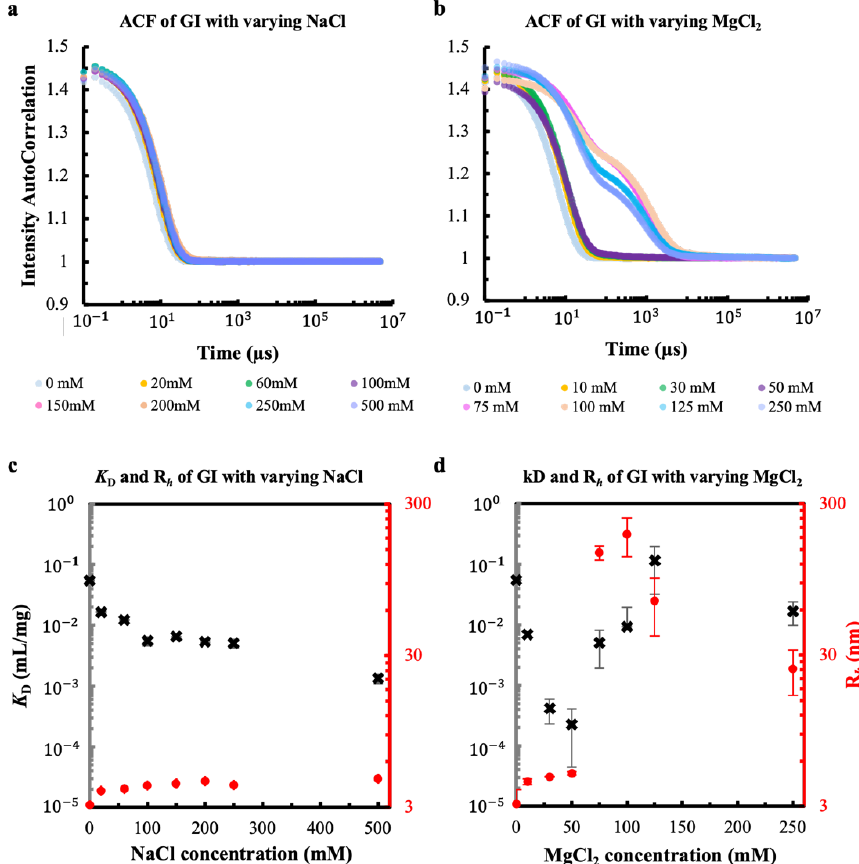
Figure 5. The auto-correlation function of a GI solution ( a ) with varying NaCl and ( b ) with varying MgCl 2 . K D values (left Y-axis, black cross) and the hydrodynamic radii (R h , right Y-axis, red dot) of GI as a function of ( c ) NaCl and ( d ) MgCl 2 concentration.